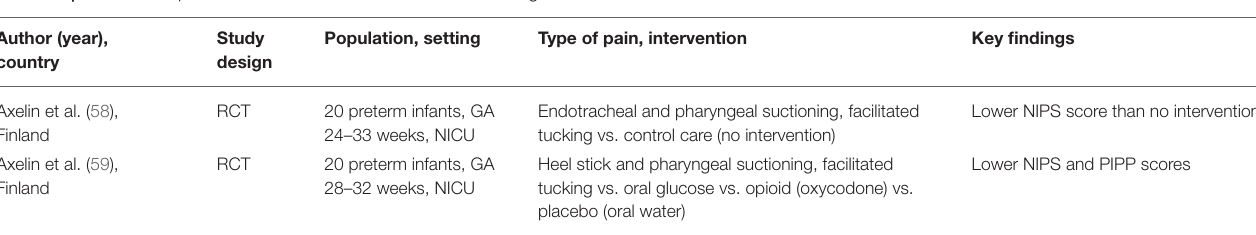
TABLE 3 | Evidence for parent-delivered interventions: facilitated tucking.